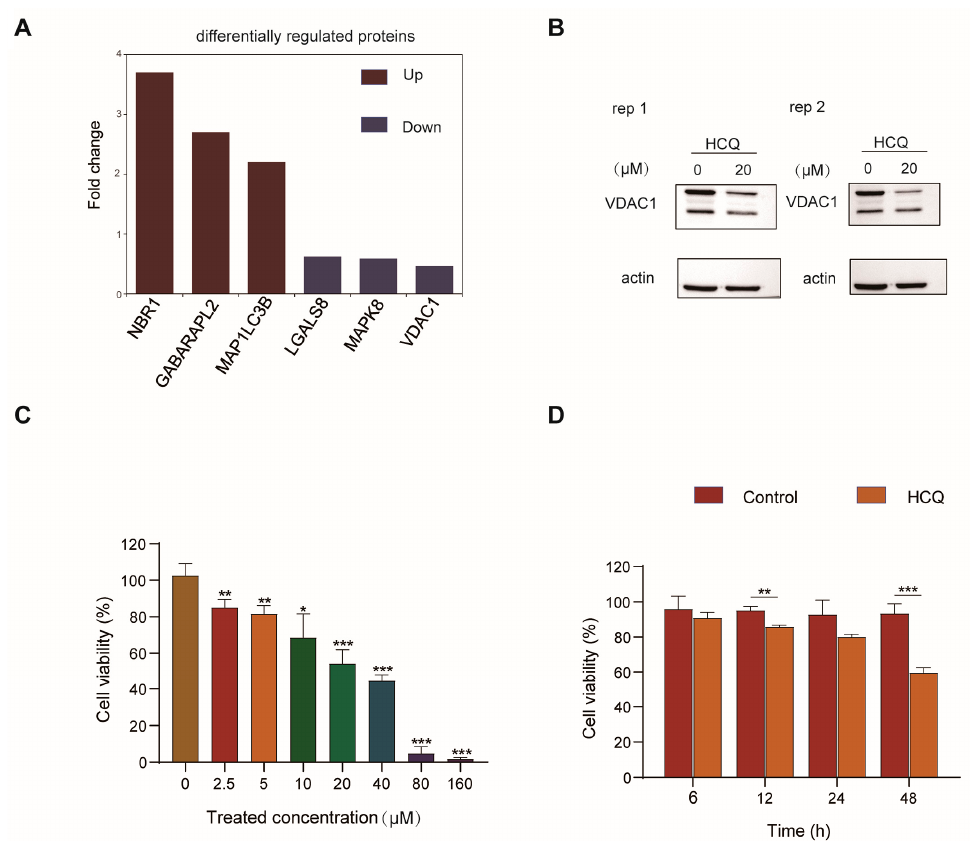
Figure 3. The validation of dynamic proteins induced by HCQ. ( A ) The representative regulated proteins induced by HCQ. Red, upregulated proteins; blue, downregulated proteins. ( B ) The Western blot validated the downregulation of VDAC1 induced by HCQ. ( C ) Cell viability of MIA PaCa-2 cells treated with different concentrations of HCQ for 48 h by Cell Counting Kit 8 (CCK-8) assay (*, p < 0.05; **, p < 0.01; ***, p < 0.001). ( D ) Cell viability of MIA PaCa-2 cells treated with 20 μ M HCQ for 0, 6, 12, 24, and 48 h by CCK-8 assay (*, p < 0.05; **, p < 0.01; ***, p < 0.001).